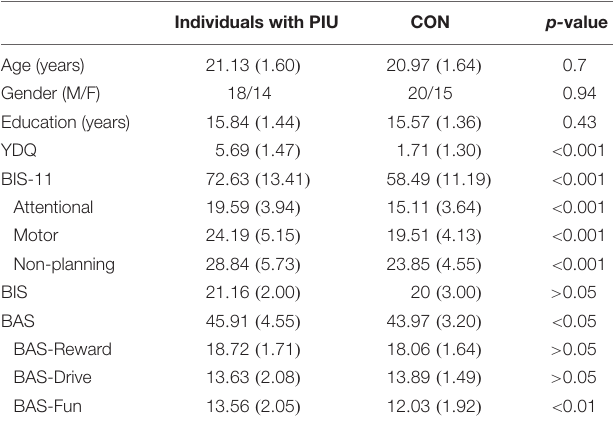
TABLE 1 | Demographic information, means (and standard deviations), and group differences between Individuals with PIU and controls. Individuals with